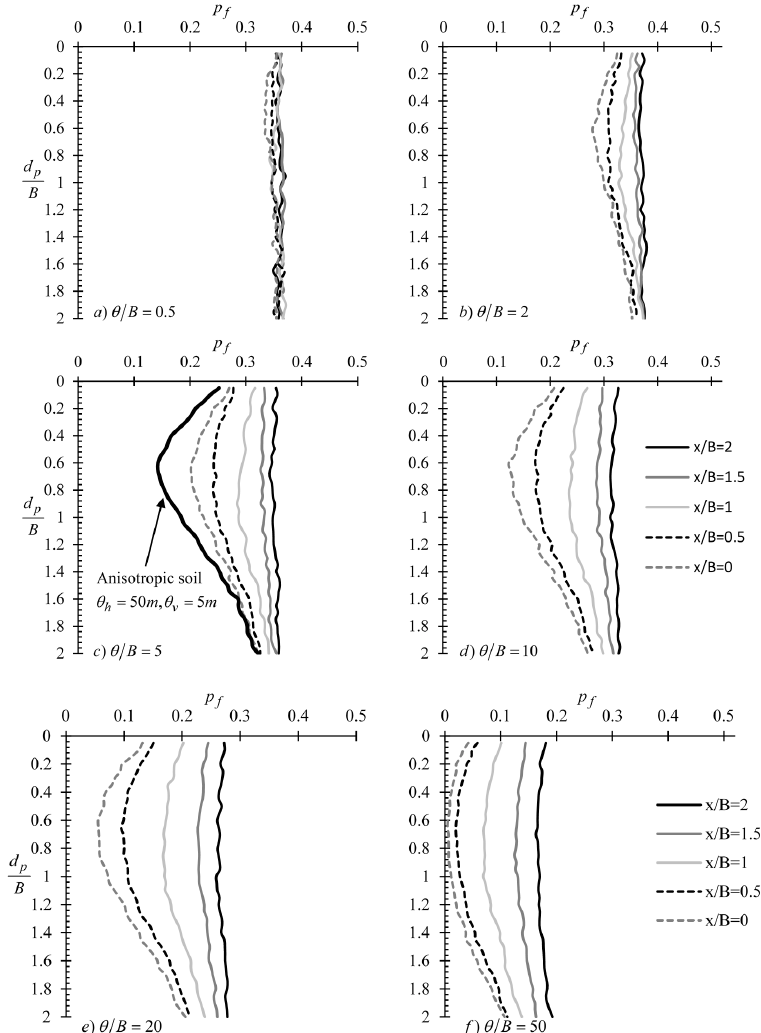
Figure 3. p f vs. d p / B example curves for various θ / B and x / B values: ( a ) θ / B = 0.5, ( b ) θ / B = 2, Figure 3. f p vs p d B example curves for various B θ and x B values: ( a ) B θ = 0.5, ( b ) B θ ( c ) θ / B = 5, ( d ) θ / B = 10, ( e ) θ / B = 20 and ( f ) θ / B = 50. The thick continuous line in ( c ) is for the = 2, ( c ) B θ = 5, ( d ) B θ = 10, ( e ) B θ = 20 and ( f ) B θ = 50. The thick continuous line in ( c ) is for anisotropic case and refers to the x / B = 0 the anisotropic case and refers to the x B = 0 case.